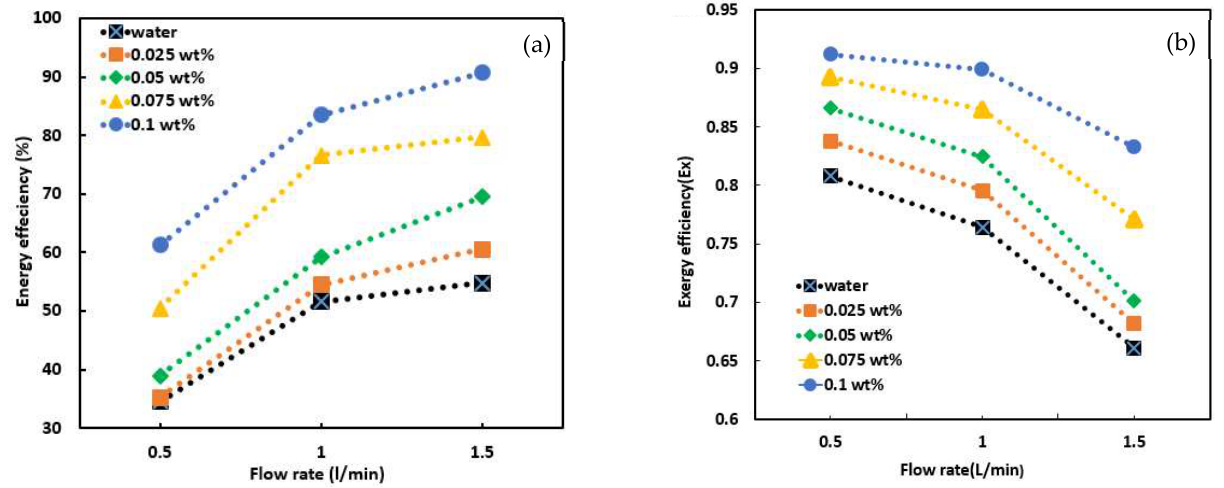
Figure 4. Impact of volumetric flow rate and particle concentration on ( a ) energy efficiency and ( b ) exergy efficiency.